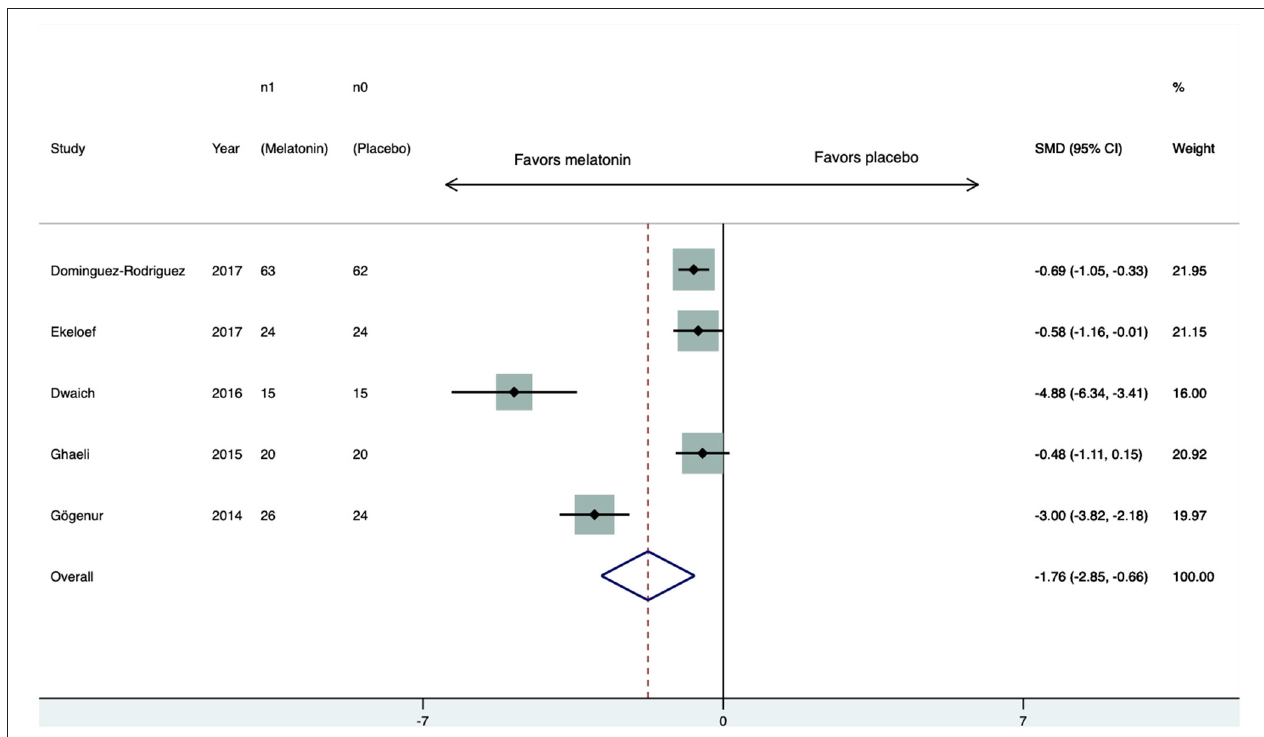
FIGURE 2 | Forest plot of troponin levels. CI, confidence interval; SMD, standardized mean difference.